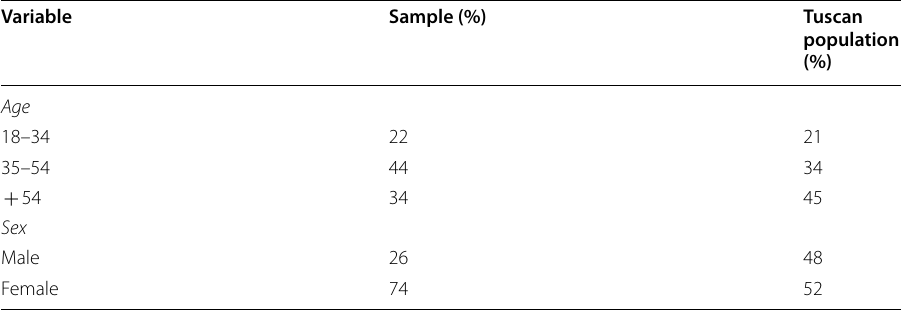
Table 2 Makeup of the sample collected compared to the Tuscan population